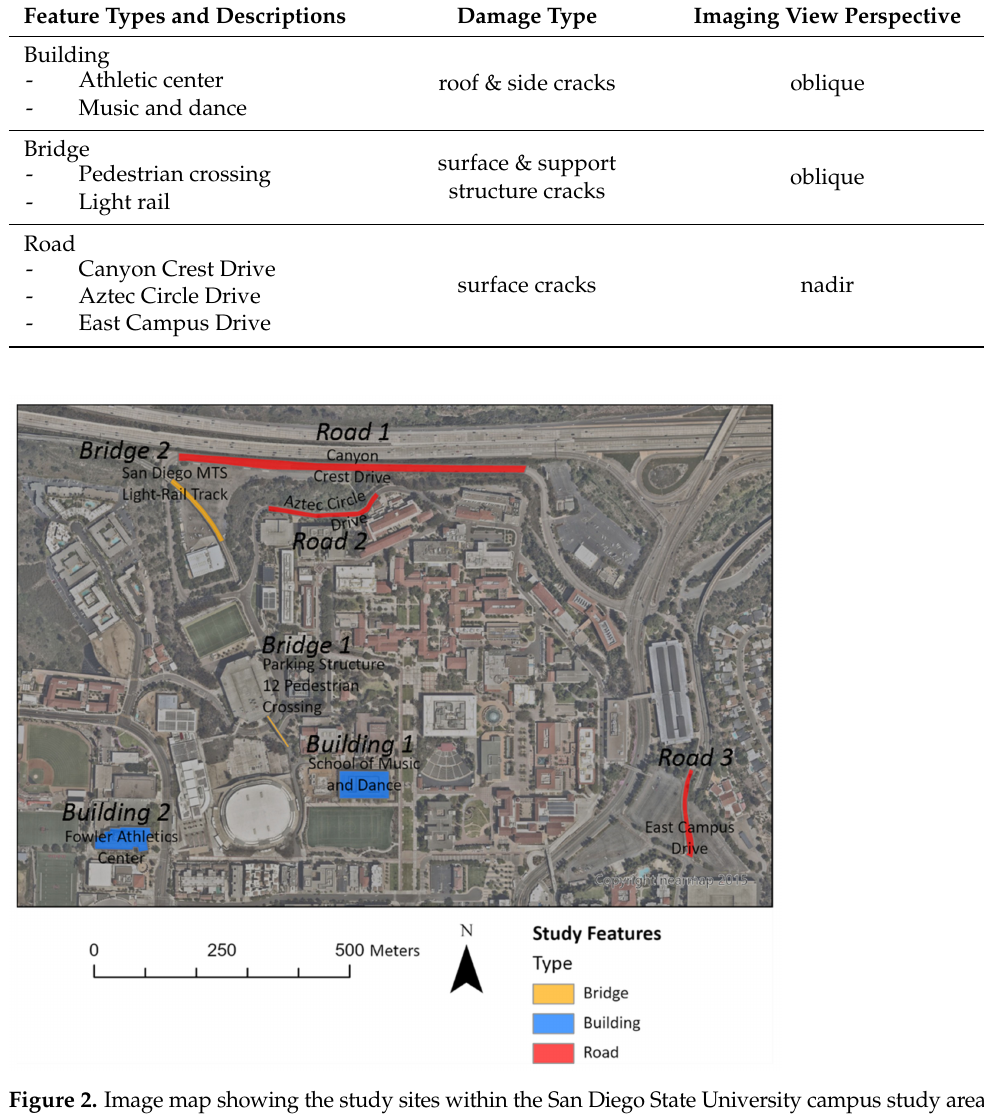
Table 1. Feature, damage, and view perspective criteria used for sUAS image collection.